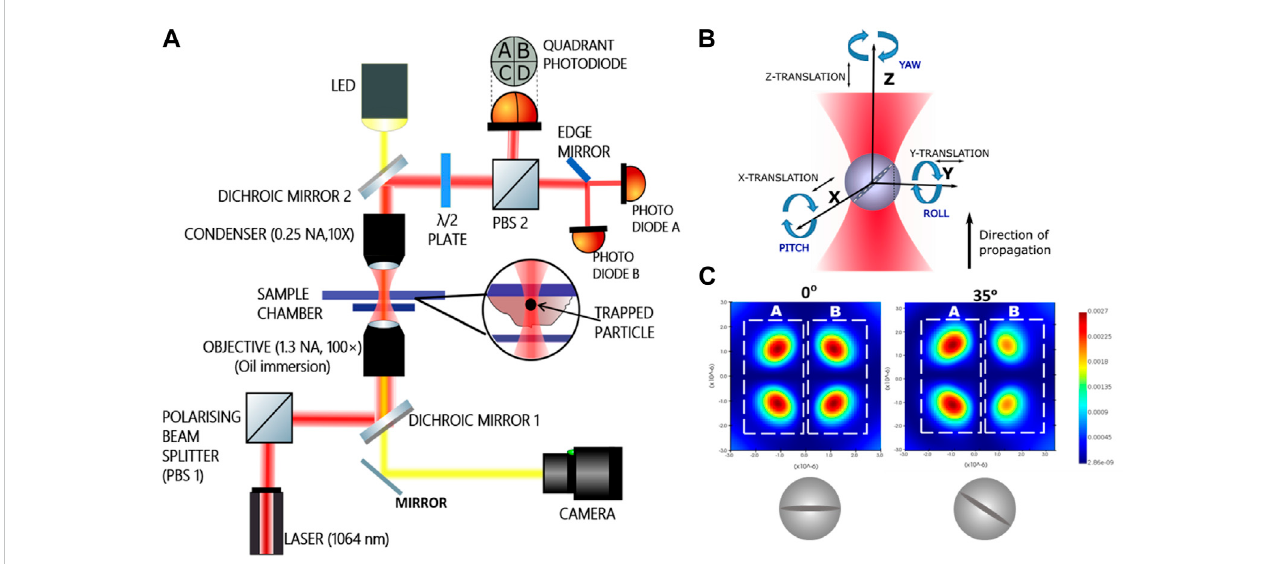
FIGURE 1 (A) Schematicdiagram oftheexperimental setup.The dichroic mirrorsare used to re fl ect the1,064 nm beamfrom thelaser to makeitpass through the samplechamberwhereitisemployedtotrapandthentothequadrantphotodiodeandthepairofphotodiodes.Cellsfedwiththeparticlesareattachedtothe upper surface of the sample chamber. (B) The three rotations with respective nomenclatures (C) intensity changes in two halves of the simulated scatter pattern from the optically trapped birefringent sphere under crossed polarizers at two different pitch angles. The halves (A) and (B) are split and made incident on respective